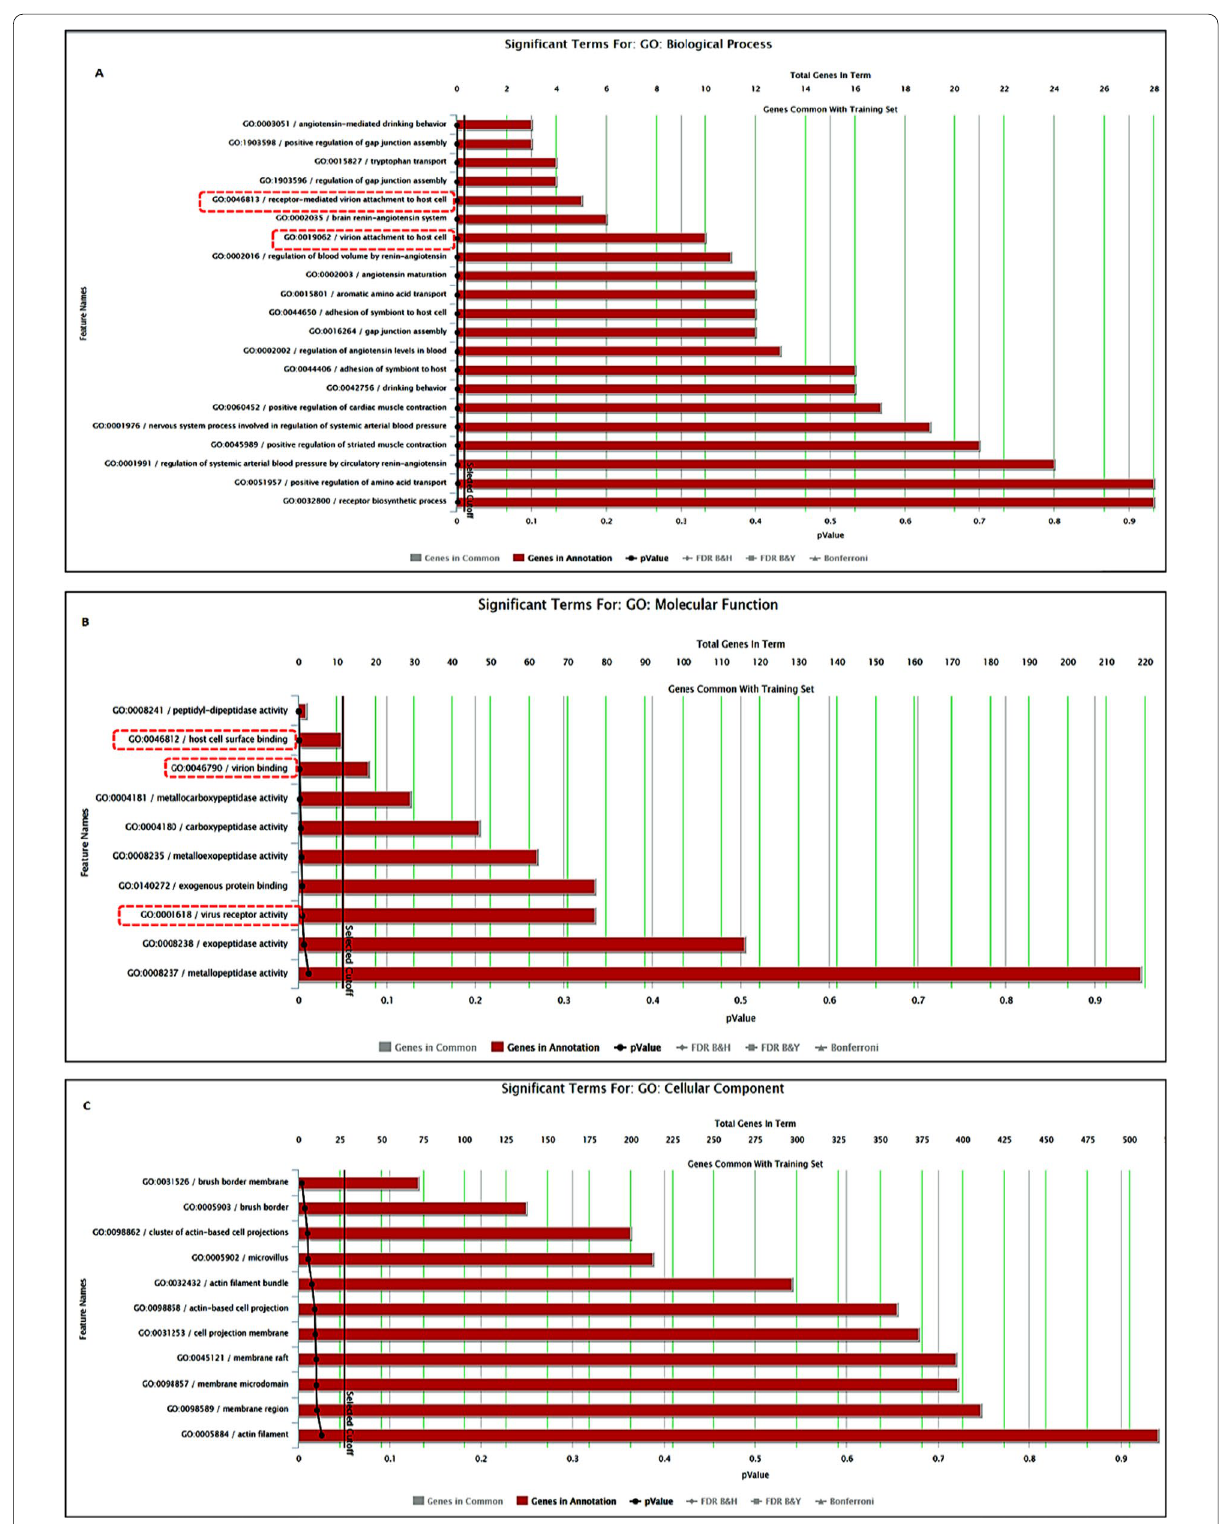
Fig. 6 Functional annotation of ACE2 . A Biological process, B Molecular functions, and C Cellular components for ACE2 with p -values set at < 0.01 for (A) and < 0.05 for (B and C). The processes and molecular functions related to coronavirus binding and infection are encircled by red broken line rectangles (https:// toppg ene. cchmc.